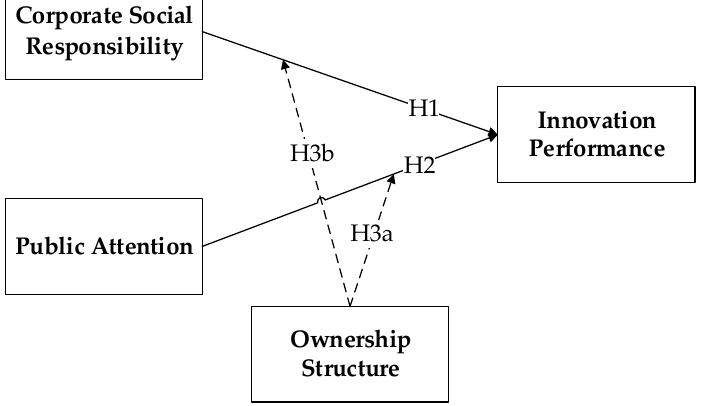
Figure 3. Research Model.